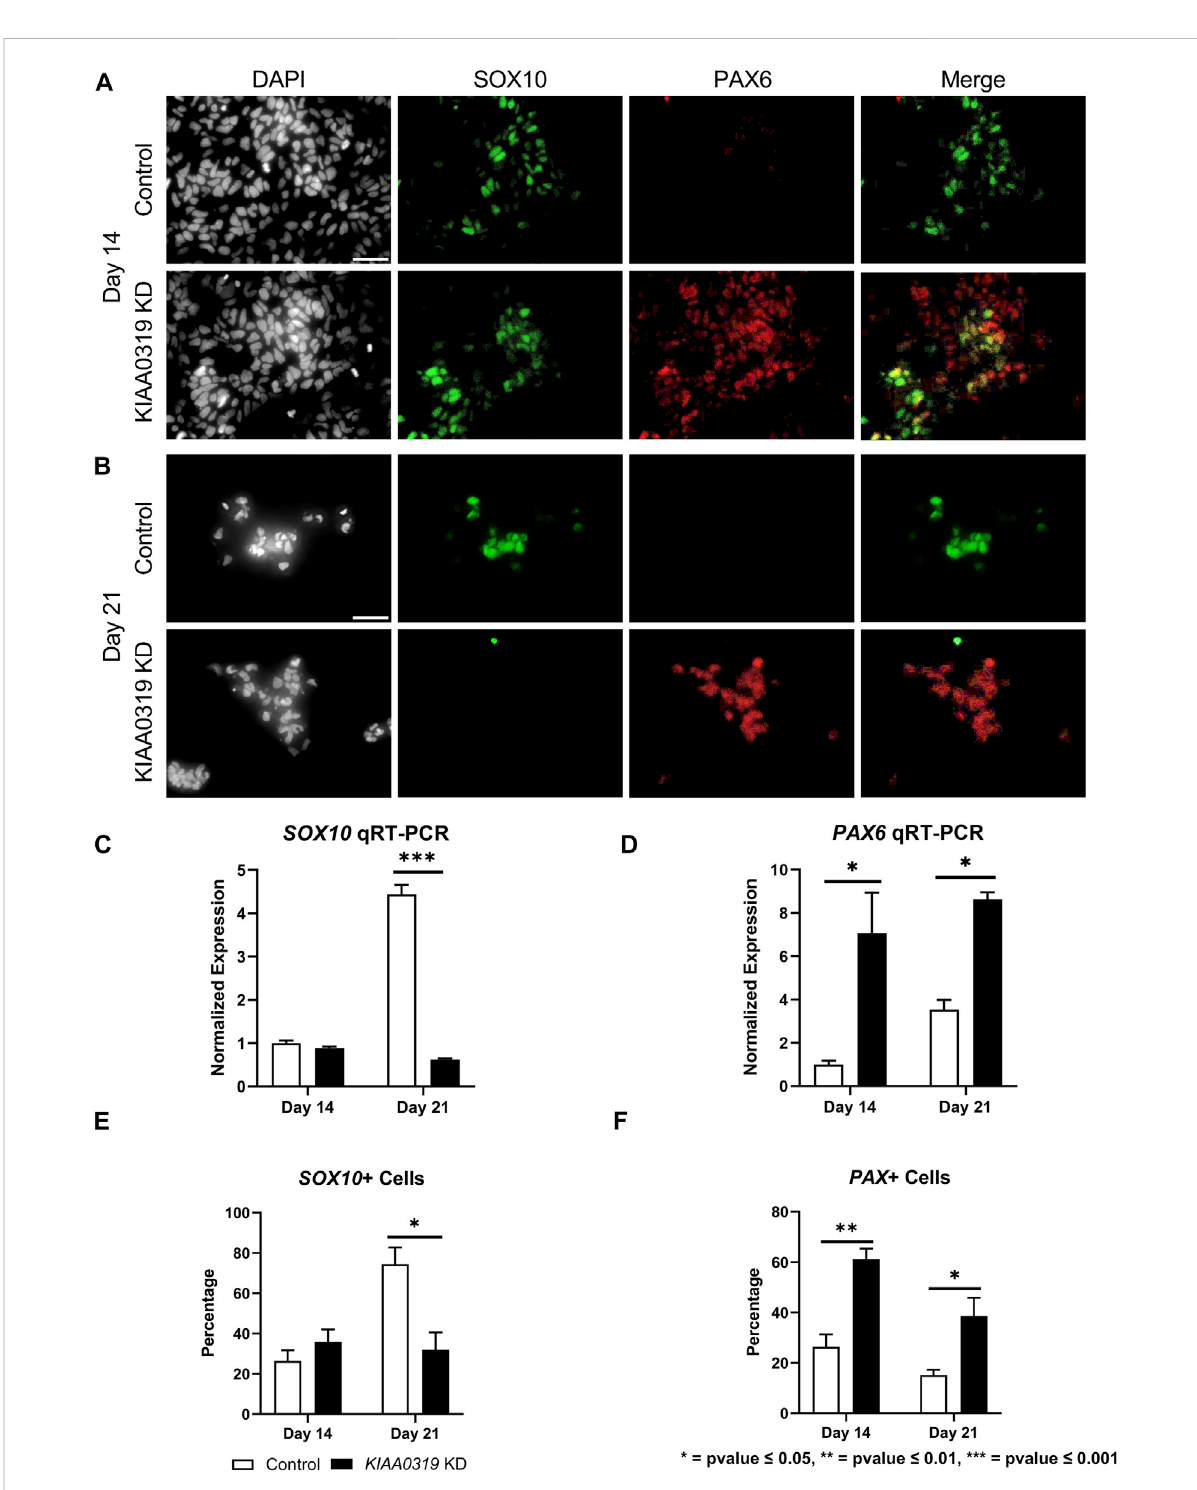
FIGURE 2 KIAA0319 KD decreases expression of neuronal epithelial marker SOX10 but increases neuronal progenitor marker PAX6. (A) After 14 days of neuronal differentiation, immuno fl uorescence was performed for SOX10 (green), PAX6 (red), and DAPI (grey). (B) After 21 days of neuronal differentiation, immuno fl uorescence was performed for SOX10 (green), PAX6 (red), and DAPI (grey). qRT-PCR for SOX10 (C) and PAX 6 (D) were performed on days 14 and 21 of KIAA0319 KD and Control H7 cells. The percentage of the population of SOX10+ (E) or PAX6+ (F) cells were calculated on day 14 and day 21 of differentiation for KIAA0319 KD and Control H7